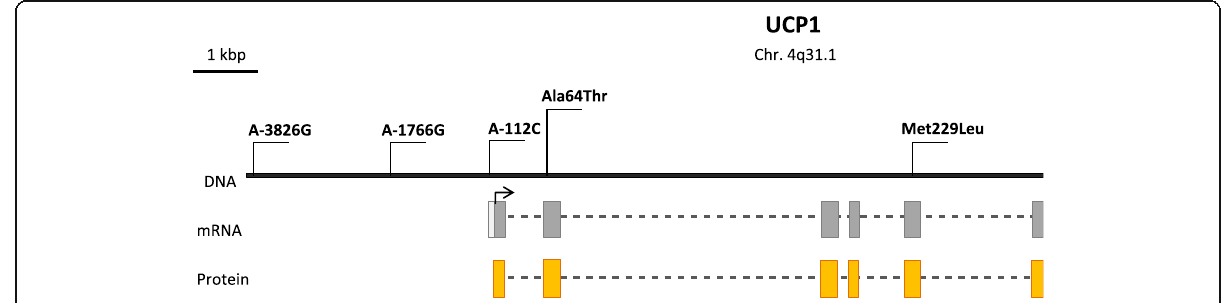
Fig. 2 Schematic structure of the Ucp1 gene and its best-studied